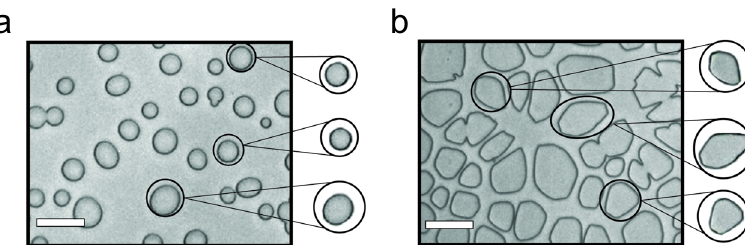
Fig. 4 Ice shaping analysis of the peptides. The images show representative cryomicrographs of ice crystals grown in PBS containing 40% sucrose in the presence of peptide 3 ( a ) and peptide 8 ( b ) at 1 mg/mL (Scale bars correspond to 100 µ m). Experiments were performed in triplicate.